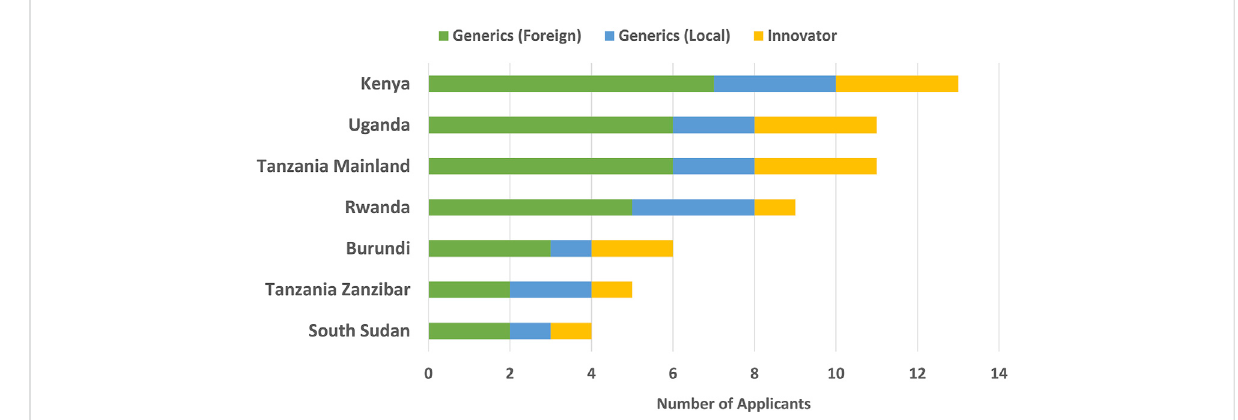
FIGURE 1 EAC countries in which companies market products.